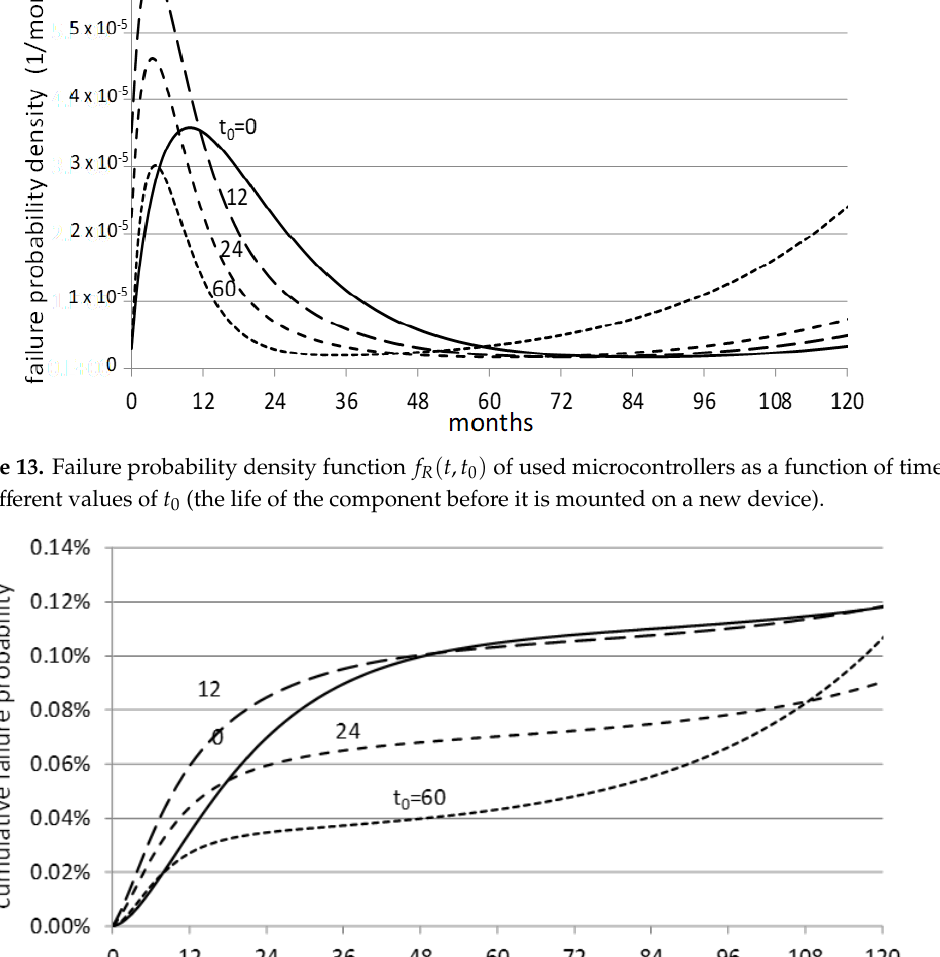
Figure 15. Cumulative failure probability 𝐹 𝑅 (𝑡, 𝑡 0 ) of used microcontrollers after 5 or 10 years as a function of its previous life. Table 4. Estimated cumulative failure probability using new components or used components in the three test boards. Board